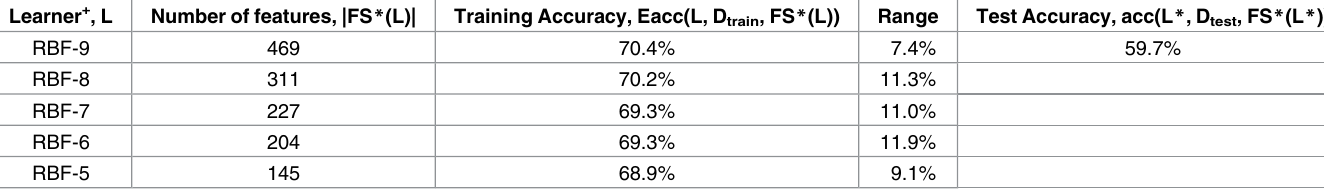
Table 5. ADHD-200,functional images.